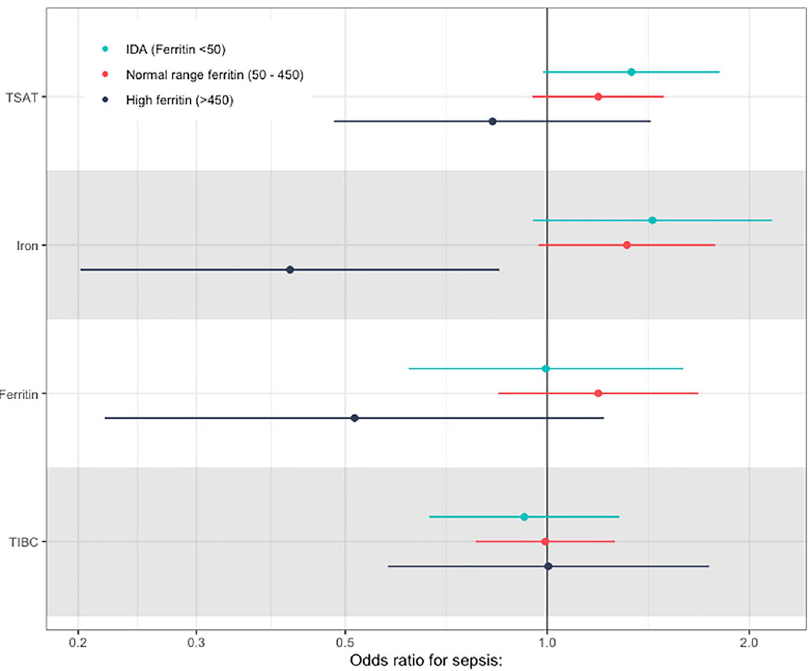
Figure 7. Odds ratios per unit SD increase in each PRS within each stratum of ferritin for each iron biomarker.